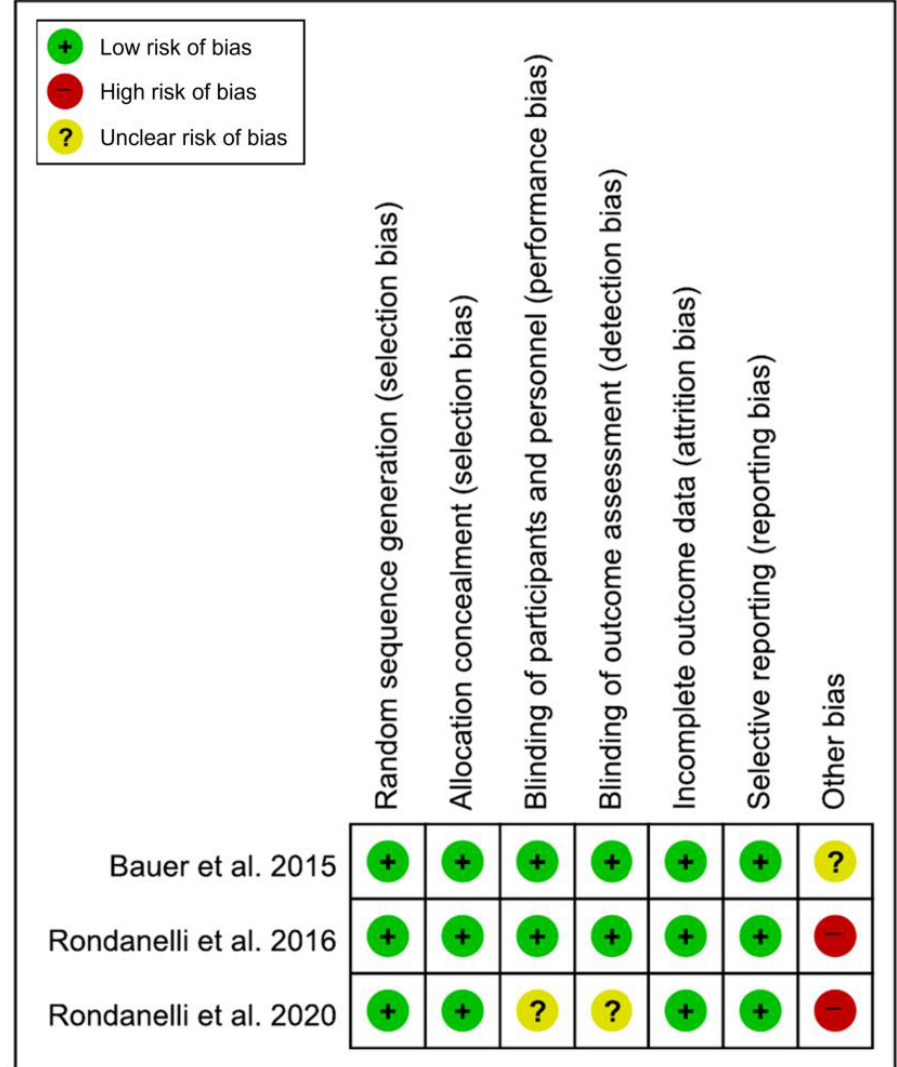
Figure 2. Results of the quality assessment of the included studies [19-21].